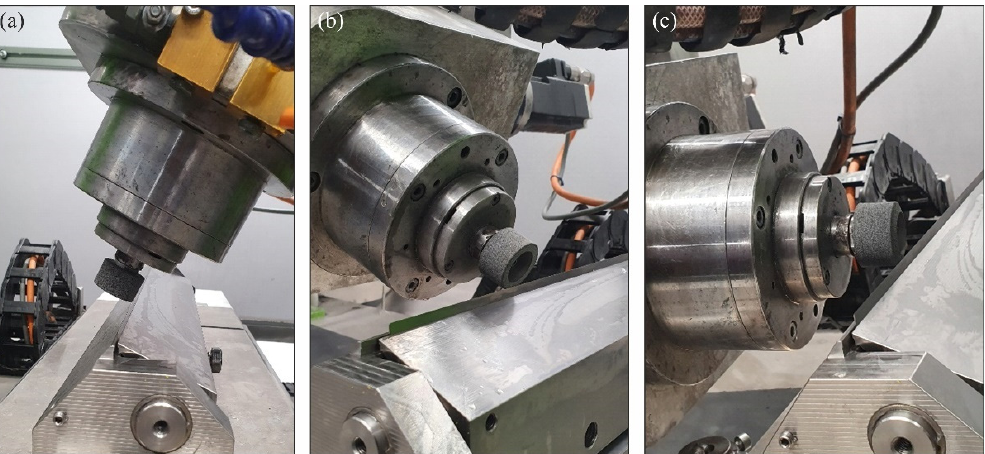
Figure 2. View of the working zone for grinding with the circumference ( a ), face ( b ) and conical surface of the grinding wheel ( c ).